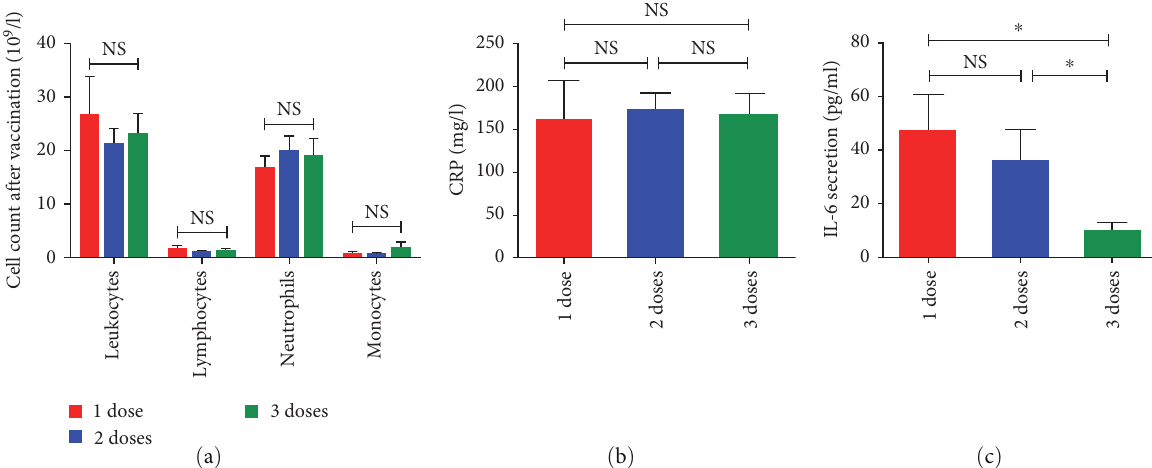
F IGURE 7: Immune response after the fi rst ( n =12), the second ( n =23), and the third dose of vaccine ( n =7): (a) cell count; (b) CRP level; (c) IL-6 secretion after each dose of vaccine. ∗ p < 0 : 05, NS, no signi fi